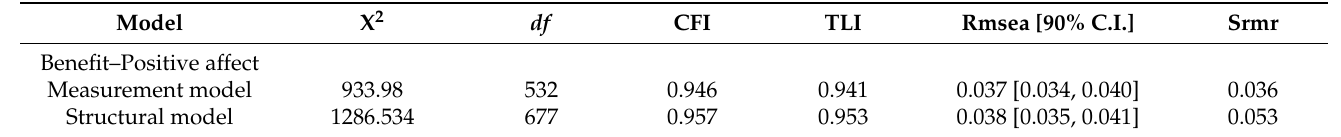
Table 3. Fit statistics for measurement model and structural model for PRISM with benefit and positive affective responses.